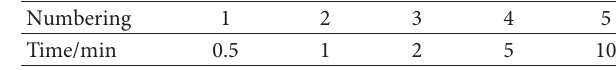
Figure 2: Schematic diagram of strain-gauge location. Table 2: Impact time of different